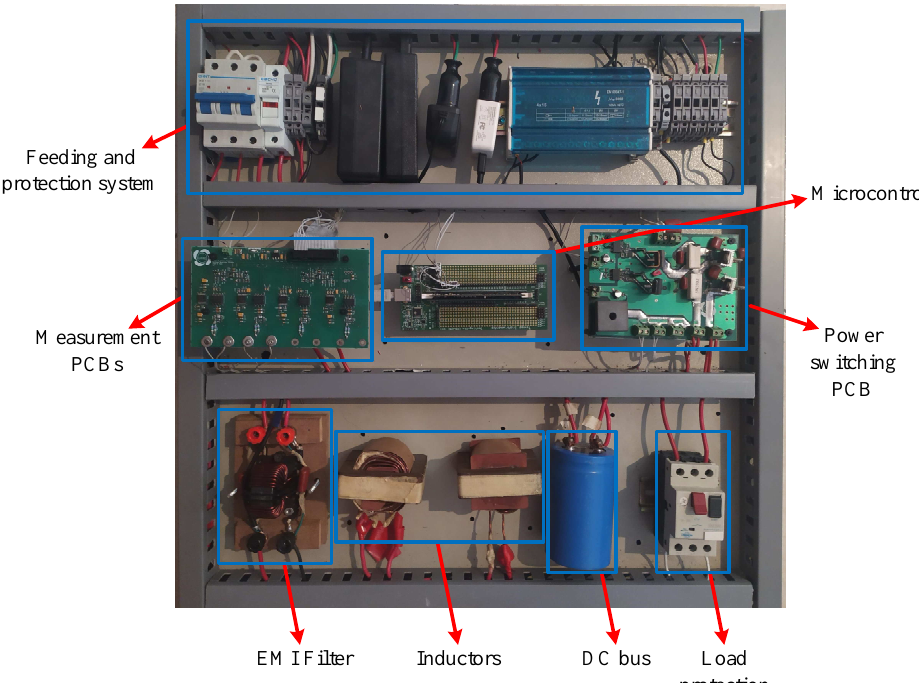
Figure 17. Semi-bridgeless boost converter for experimental tests.